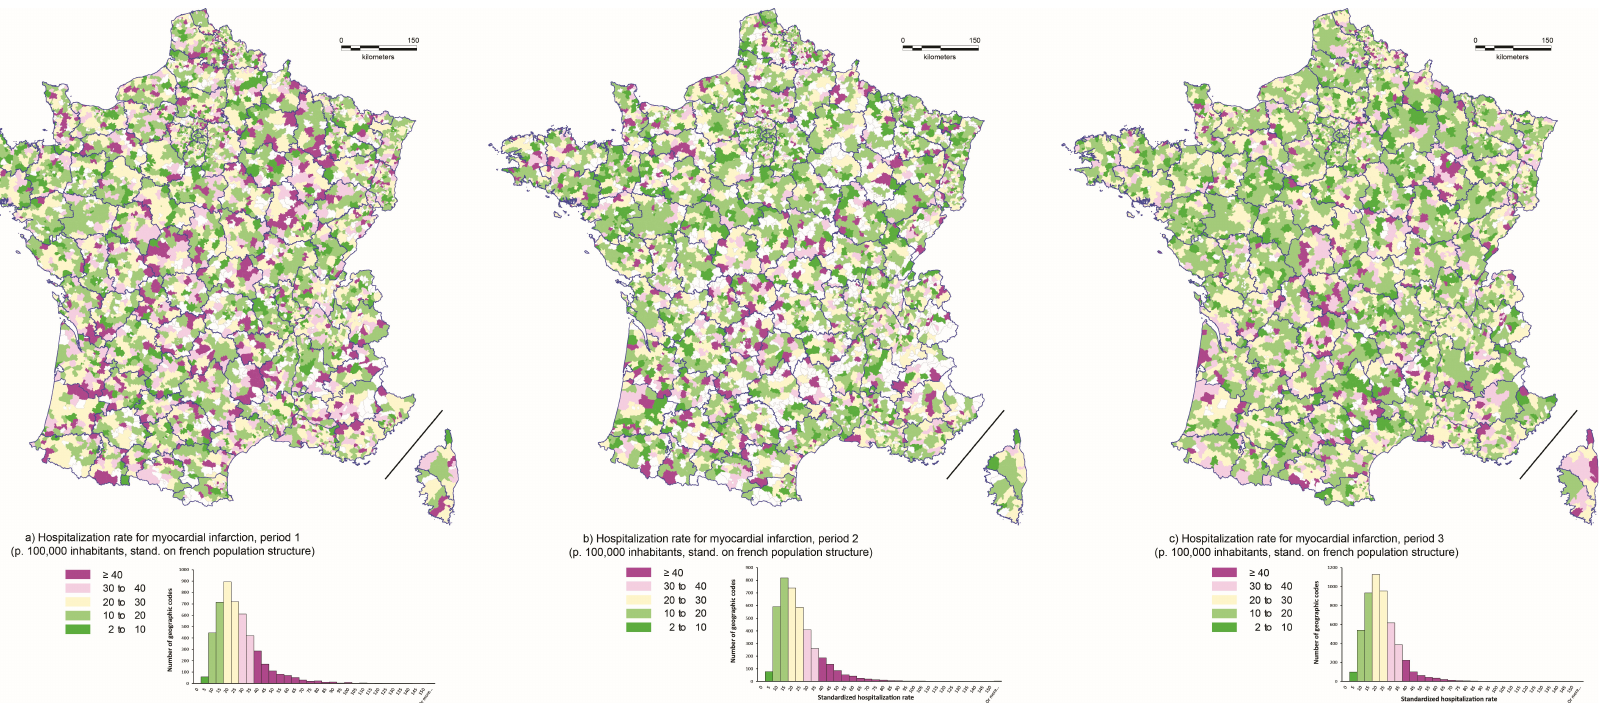
Figure 3. Hospitalization rate for myocardial infarction by periods and postal zip-codes in 2020. Legend: Hospitalization rates are standardized on French population structure and expressed per 100,000 inhabitants. Periods are defined as: ( a ) period 1 = before the lockdown (1 January to 16 March 2020), ( b ) period 2 = during the lockdown (17 March to 10 May 2020) and ( c ) period 3 = after the lockdown (11 May to 30 September